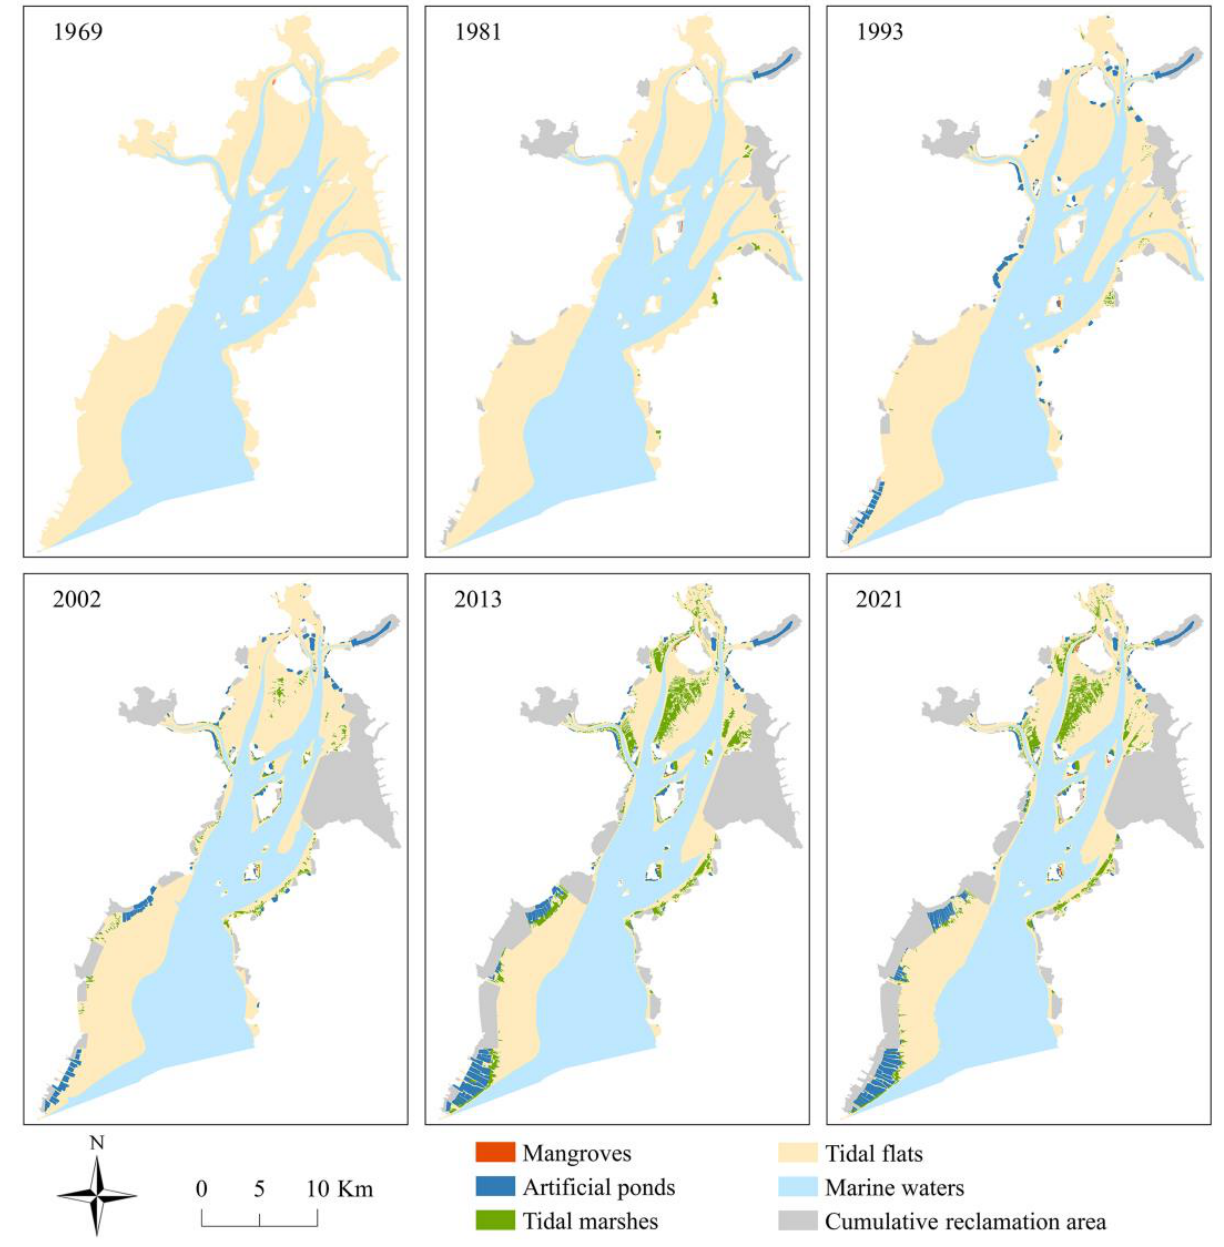
Figure 5. Map of wetland types distribution in Yueqing Bay from 1969 to 2021. The most detectable transformation of various tidal wetland types in Yueqing Bay occurred from tidal flats to land (reclamation area), tidal marshes, and artificial ponds, and showed pronounced phased characteristics (Figure 6). From 1969 to 1993, the conversion from tidal flats to land was the main type of wetland variation during this time interval, with an area of 38.63 km 2 . The area of shallow marine waters silted into tidal flats was 21.87 km 2 . From 1993 to 2021, the conversion between various wetland types was more complex than in the previous time interval. The conversion area from tidal flats to land reached 58.53 km 2 . The area from the water area to tidal flats was 24.99 km 2 . The relatively large area was the conversion from tidal flats to tidal marshes and artificial ponds, both with the area of 19.69 km 2